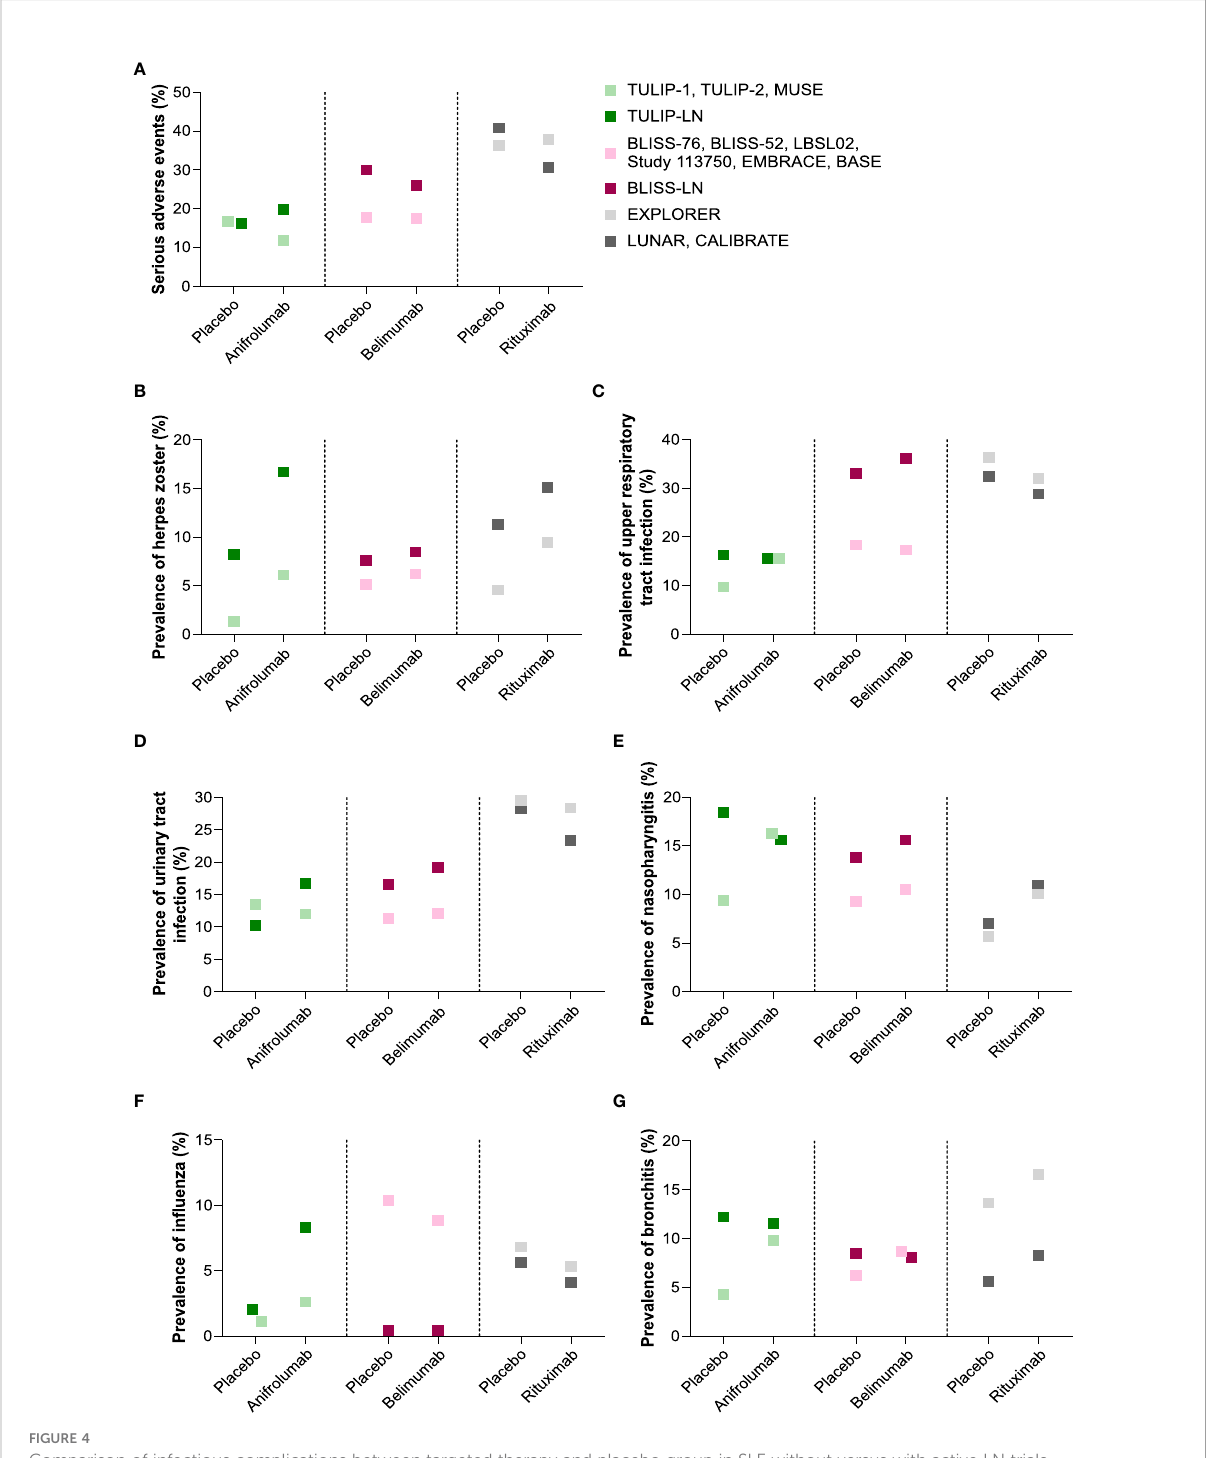
FIGURE 4 Comparison of infectious complications between targeted therapy and placebo group in SLE without versus with active LN trials . (A) Comparison of serious adverse events in patients receiving the targeted therapy versus placebo in the systemic lupus erythematosus (SLE) without active lupus nephritis (LN) trials that are reported in the anifrolumab (TULIP-1, TULIP-2, MUSE), belimumab (BLISS-76, BLISS-52, LBSL02, Study 113750, EMBRACE, BASE) and rituximab (EXPLORER) trials and in the active LN trials that are reported in the anifrolumab (TULIP-LN), belimumab (BLISS-LN) and rituximab (LUNAR/CALIBRATE) trials. (B – G) Comparison of the prevalence of herpes zoster (B) , upper respiratory tract infection (C) , urinary tract infection (D) , nasopharyngitis (E) , in fl uenza (F) , and bronchitis (G) in patients receiving the targeted therapy versus placebo in the SLE without active LN trials and active LN trials as listed in (A)